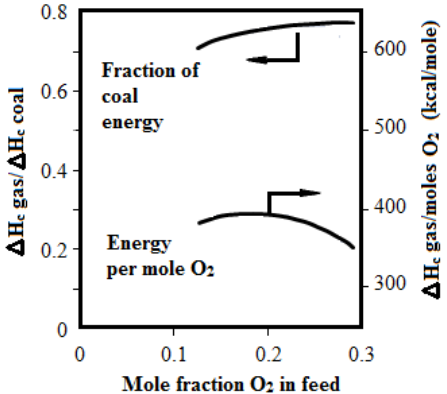
Figure 7. Calculated energy recovery for three levels of oxygen feed concentration [48].